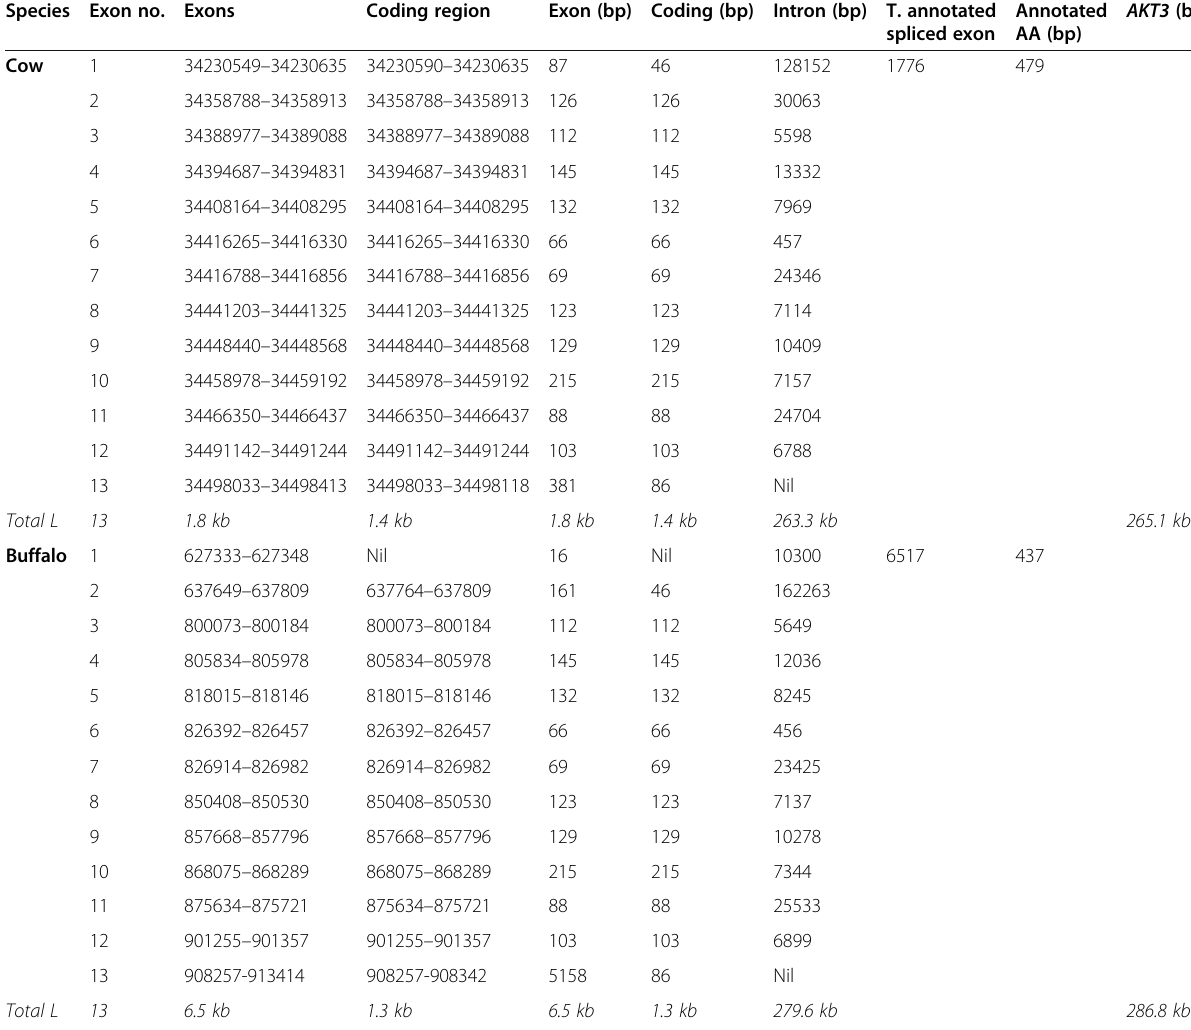
Table 3 Features of parts of AKT3 length by base pair (bp) for cow and buffalo Species Exon no. Exons